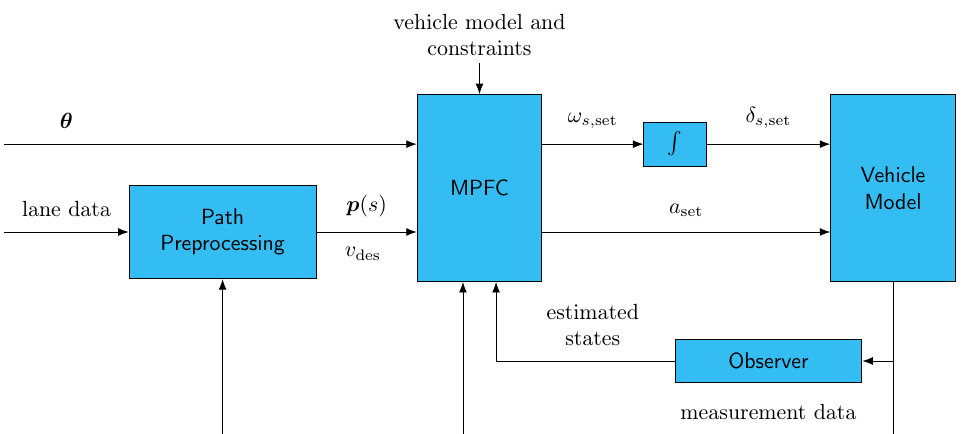
Figure 2. MPC implementation for longitudinal and lateral vehicle control based on a model predic- tive path-following control (MPFC) approach. Based on a specific parameter vector θ , the reference path p ( s ) and the desired velocity v des the MPFC yields the target acceleration a set and the steering wheel target angular velocity ω s,set (and, subsequently, the steering wheel target angle δ s,set ), which are used as an input to the vehicle model.